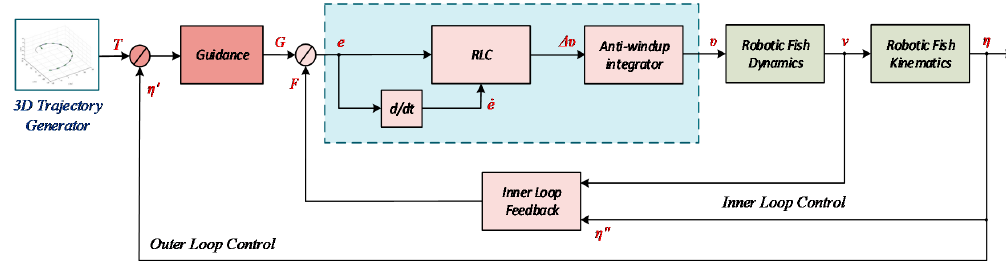
Figure 13. Thrust force of the robotic fish for free-swimming motion during 80s simulation time.